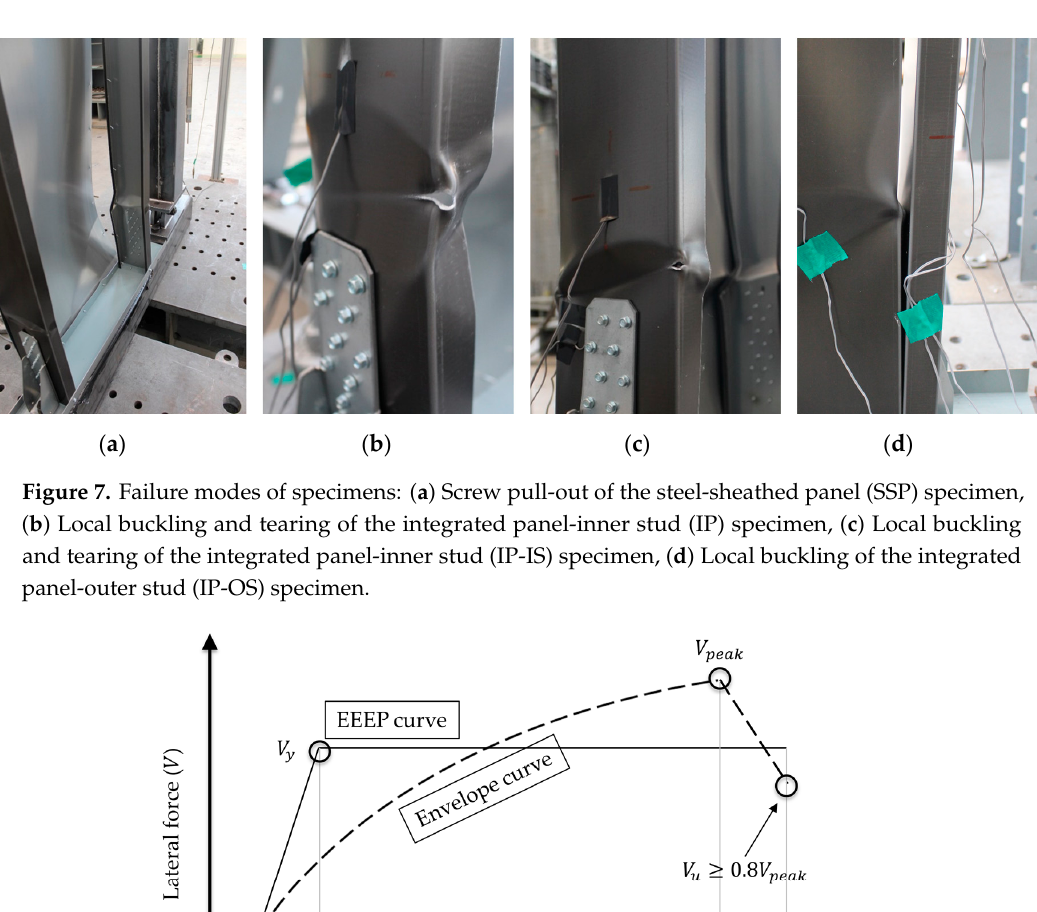
Figure 6. Lateral load–drift ratio relationships and failure modes of specimens: ( a ) The steel- integrated panel-inner stud (IP-IS) specimen, ( d ) The integrated panel-outer stud (IP-OS) specimen.